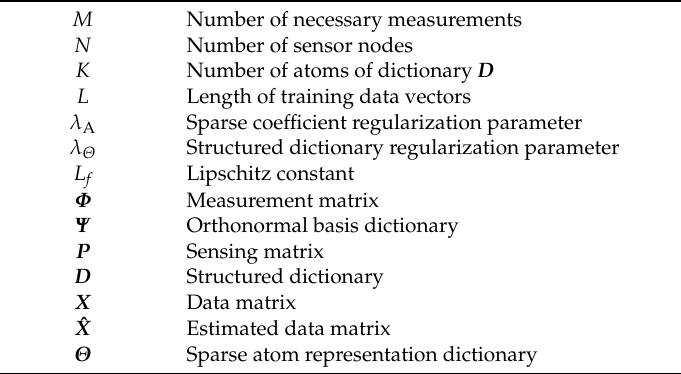
Table 1. Summary of